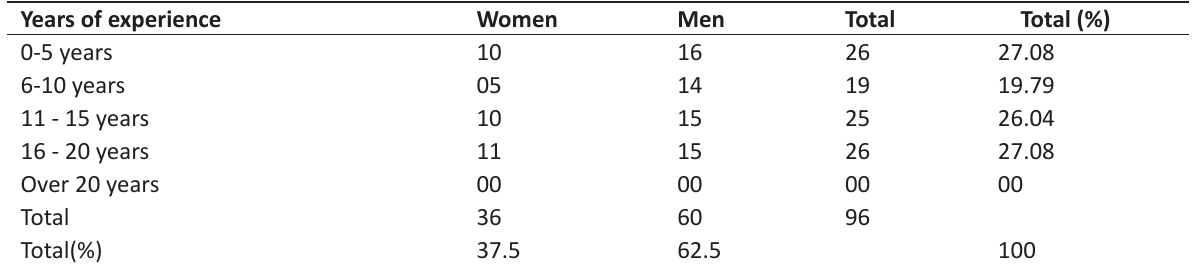
Table 1. Characteristics of the participants included in the study (n = 96). Years of experience